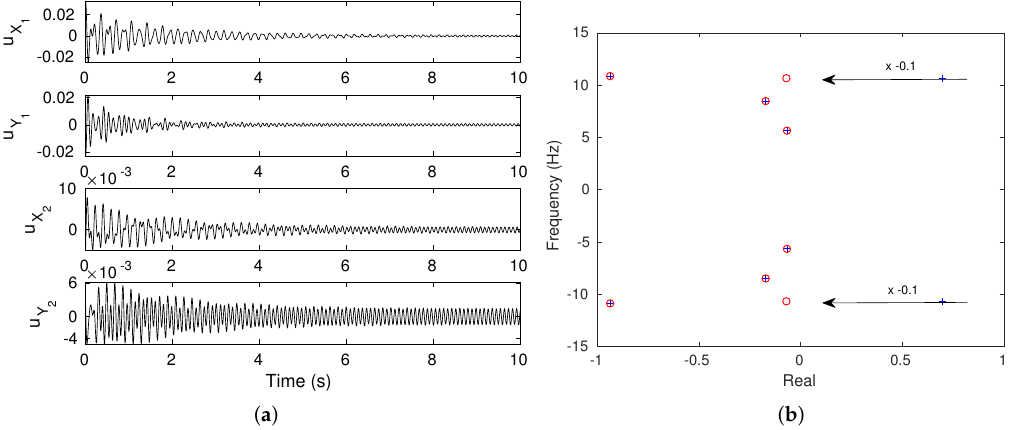
Figure 7. Control vector u applied to the displacements and poles chart with γ = − 0.1 and µ = 0.4. ( a ) Control vector. ( b ) Poles chart ( + uncontrolled poles; ◦ controlled